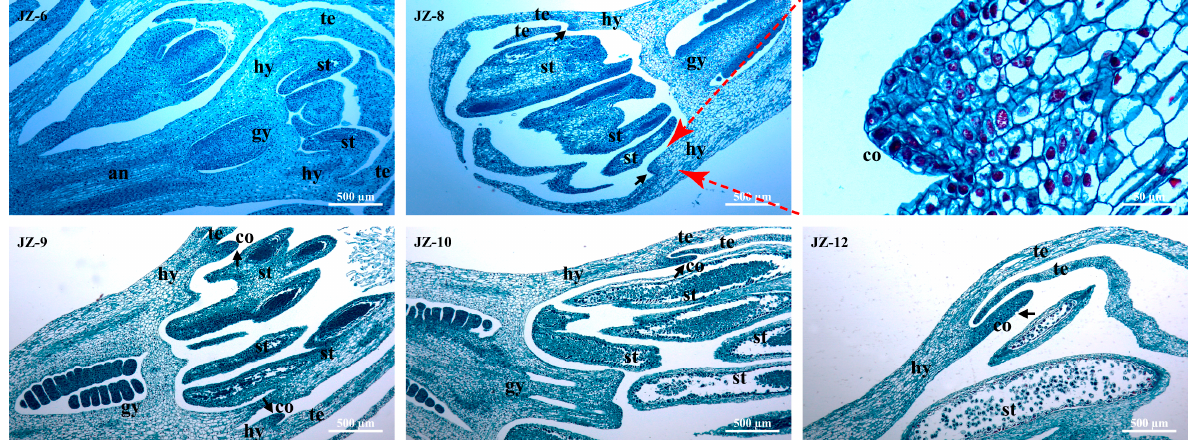
Figure 3. Longitudinal paraffin sections of the JZ corona during morphogenesis. an—anthophore; hy—hypanthium; gy—gynoecium; te—tepal; st—stamen; co—corona.